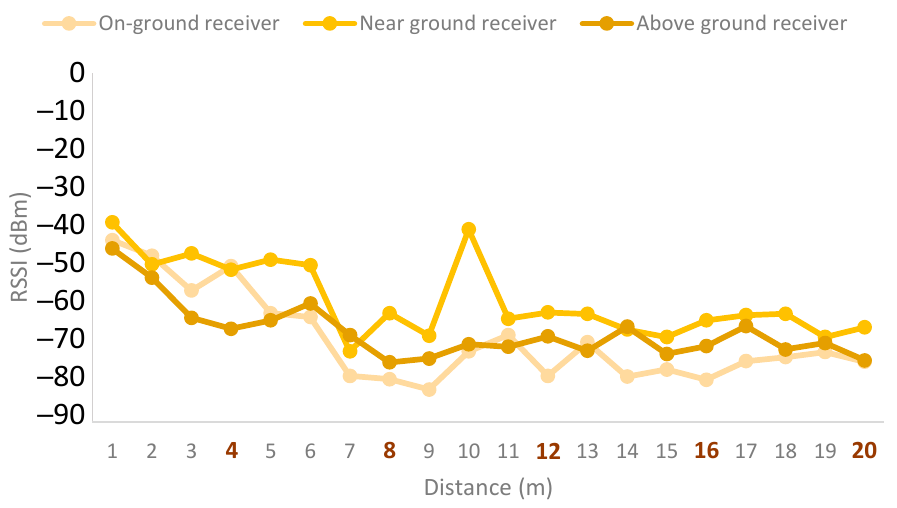
Figure 16. Emitter at height of 1.5 m.